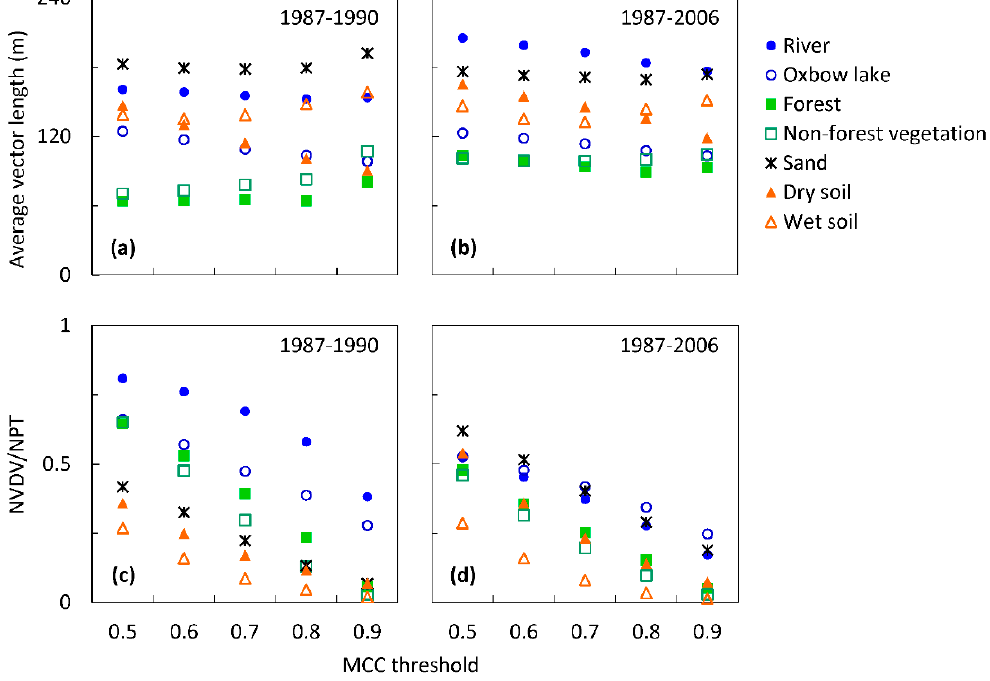
Figure 5. Sensitivity of MCC method to MCC threshold. Average valid displacement vector length for the periods of ( a ) 1987–1990 and ( b ) 1987–2006, and the ratio of the number of valid displacement vectors (NVDV) to the number of possible templates (NPT) for the periods of ( c ) 1987–1990 and ( d ) 1987–2006 as a function of MCC threshold. Template size = 13 × 13 pixels, search window size = 31 × 31 pixels.